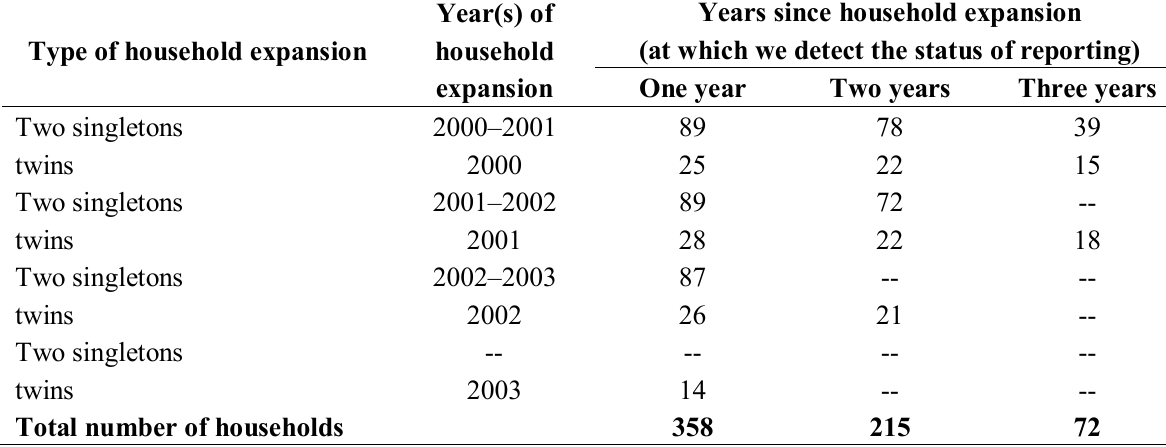
Table 1. The working datasets—number of households by type and reporting status.